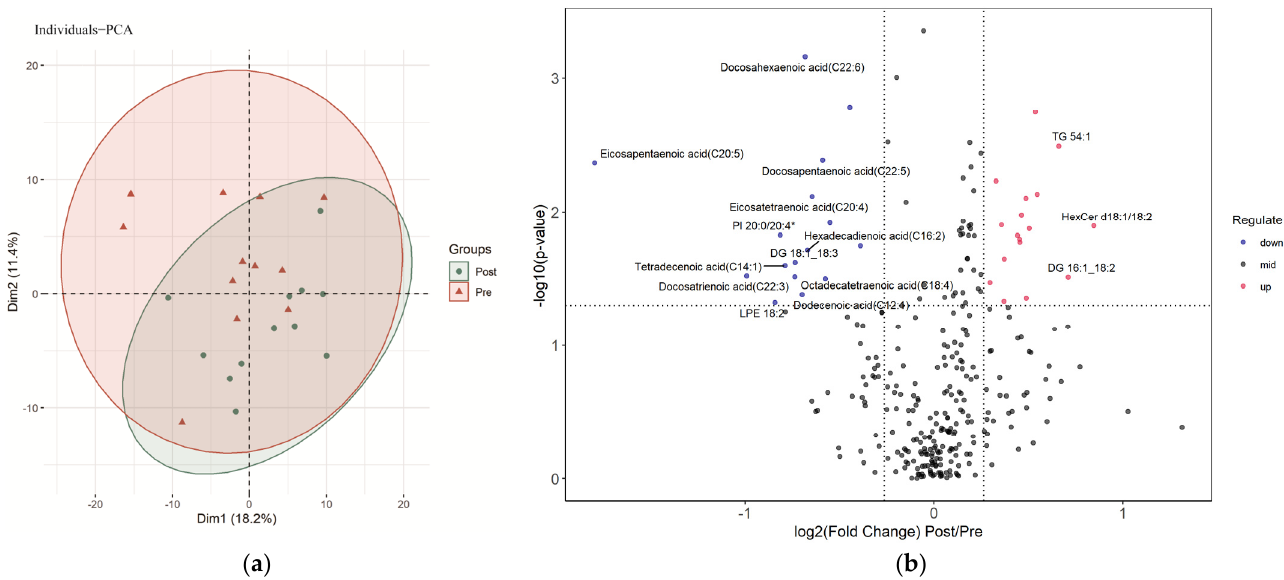
Figure 1. Characterization of serum lipids pre- and post-sprint interval training: ( a ) PCA (principal component analysis) of serum lipids pre- and post-sprint interval training; ( b ) volcano plot demon- strating the changes in serum lipids induced by sprint interval training. Lipids with labeling fold change > 1.5 or <1/1.5 and p < 0.05.